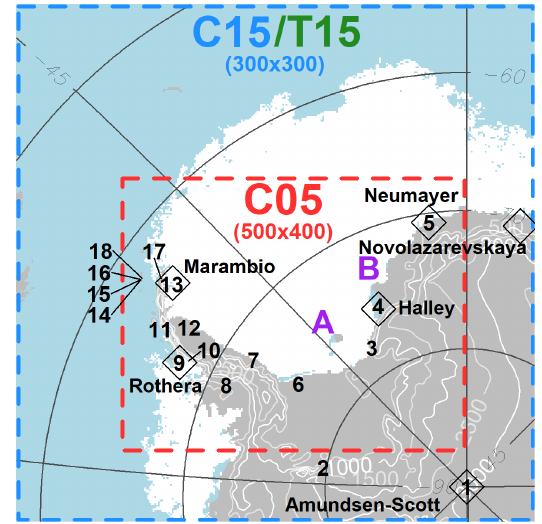
Figure 1. Overview of the C15/T15 (blue/green) and C05 (red) simulation domains, locations of six radio sounding stations (di- amonds), surface/automatic weather stations (numbers), and loca- tions of the RV Polarstern during our two case studies A and B (purple). Topography contours are plotted every 500m, and sea ice concentration > 70% for the 1 June 2015 is shown in white. (Note that the T15 domain is the same as the C15